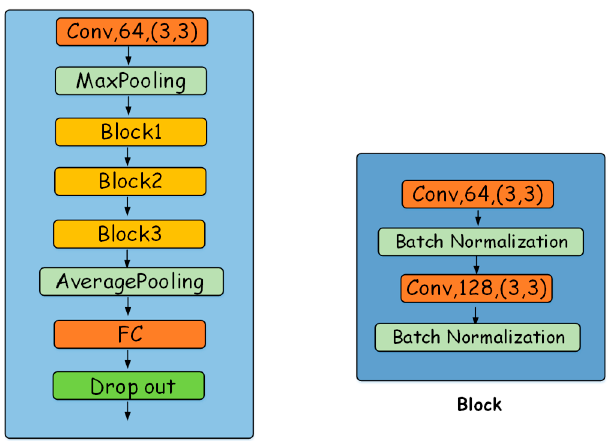
Figure 4. Convolutional module. “conv, 64, (3,3)” refers to one convolutional layer with 64 filters and the kernel size is 3 × 3.